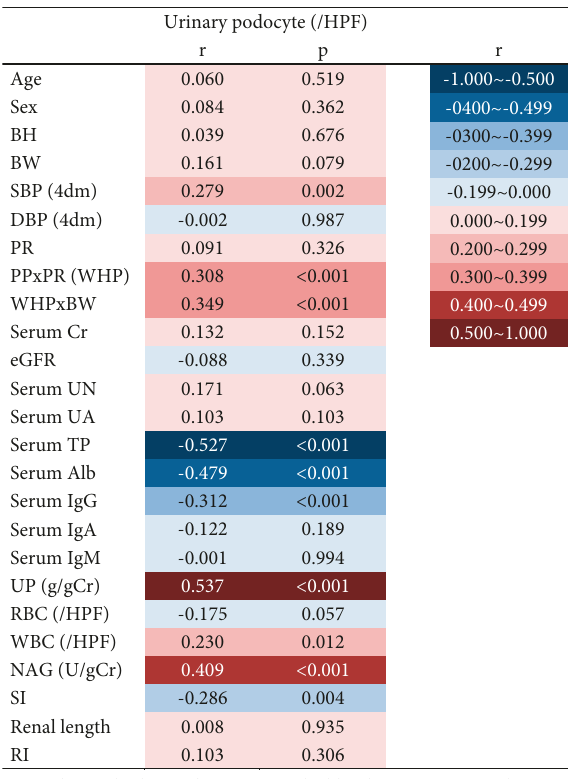
BW indicates body weight; SBP, systolic blood pressure; PP, pulse pressure; PR, pulse rate; WHP, water hammer pressure; UP, urinary protein; NAG, N-acetyl- β -D-glucosaminidase; Tf, transferrin; MG, microglobulin; SI, selectivity index; RI, resistive index.